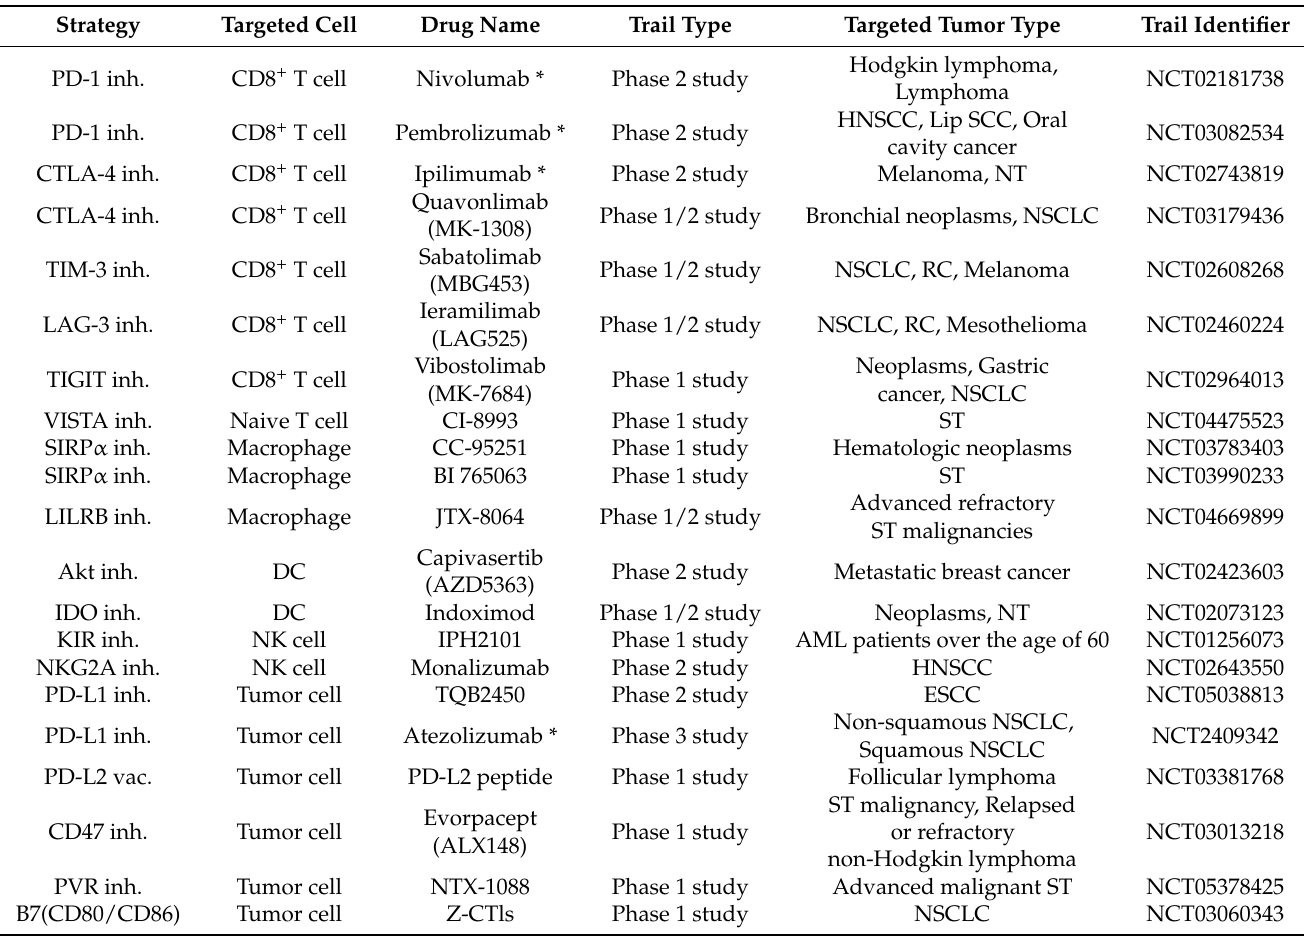
Table 1. Clinical trials of different kinds of ICIs for